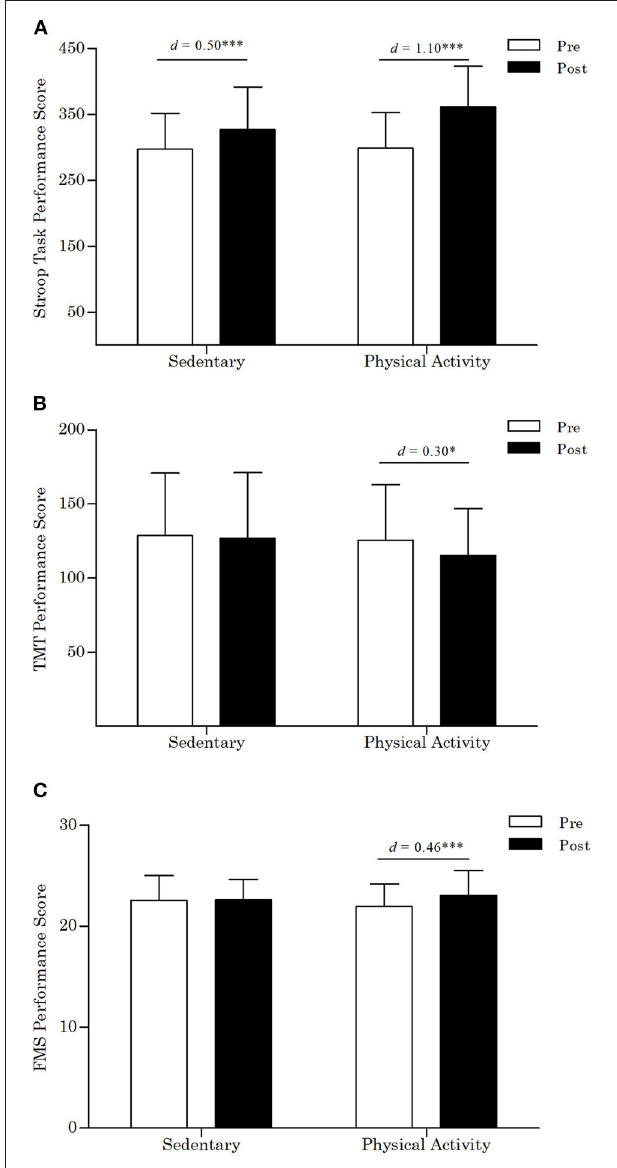
FIGURE 5 | (A) Stroop task performance scores by condition. (B) Trail making test performance scores by condition. TMT, trail making test. Lower scores indicate better performance on the TMT. (C) Forward memory span test scores by condition. FMS, forward memory span test. d , Cohen’s d , *** p < 0.001, * p < 0.05. Error bars represent SD of the